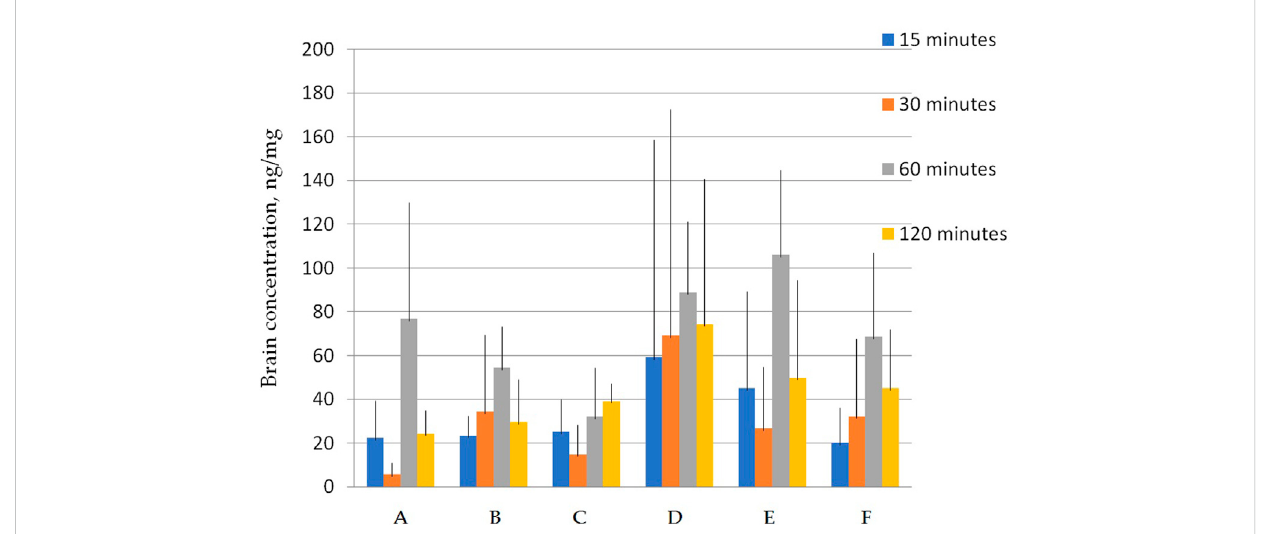
Concentrationoflatrepirdineforpolymorphs (A – F) inbraintissuesamples.Dataarepresentedasmeanvaluesforeachpolymorphataspeci fi ctime point + standard